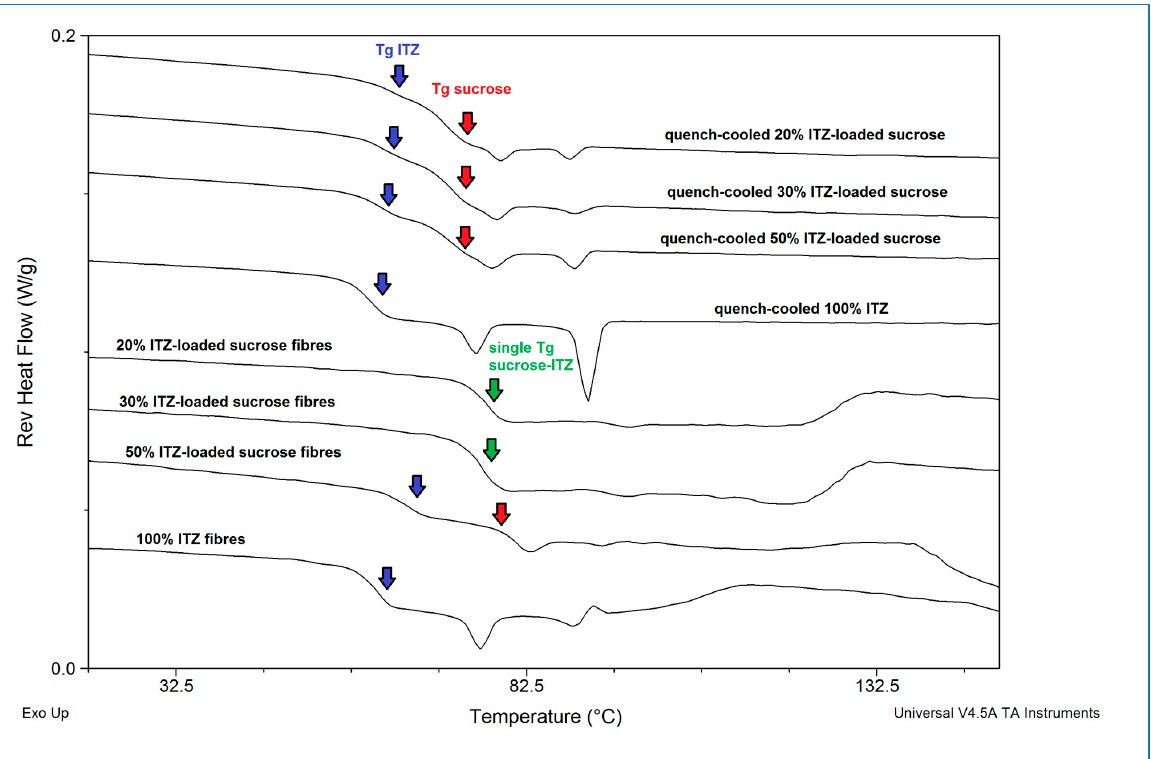
Figure 3. Reversing heat flow traces of freshly prepared itraconazole-loaded sucrose microfibres (containing 20, 30, and 50% w / w itraconazole), pure itraconazole microfibres, and solid dispersions with equivalent compositions prepared by quench-cooling from the melt. (ITZ = itraconazole). All samples showed glass transitional behaviour, indicating the generation of amor- phous dispersions. Interestingly, the quench-cooled sucrose-itraconazole samples all showed two separate glass transitions assigned to the individual components, with that of sucrose occurring at 68 ± 4.3 °C, indicated with a red arrow, and that of itraconazole occurring at 60 ± 0.2 °C, indicated with a blue arrow. These data indicate phase separation, i.e., lack of miscibility, of the two components, as discussed previously [35] for other sys- tems. Further evidence of phase separation is offered by the presence of the two endother- mic events occurring at around 74 and 90 °C, ascribed to the formation of a chiral nematic mesophase of pure itraconazole (90 °C) and rotational restriction of the molecules (74 °C) upon cooling from the melt, which are reversible upon re-heating, leading to the observed endotherms [36]. Both of these endothermic transitions and the glass transition are clearly visible for the quench-cooled pure itraconazole sample here. Microfibres containing 20 and 30% w / w itraconazole showed a single mixed-phase glass transition, indicated with a green arrow, at 74.7 ± 1.1 °C and 73.2 ± 1.3 °C, respectively, similar to that observed for the 10% w / w drug-loaded sample at 74.1 ± 1.9 °C [4]. Conversely, the thermal behaviour of the 50% w / w itraconazole-loaded microfibres was more similar to that of the corre- sponding quench-cooled sample, with both individual substance glass transitions and both itraconazole endothermic events being observed. It is interesting to note that the en- dothermic transitions are less pronounced for the microfibres, possibly indicating a lower degree of phase separation compared with the equivalent quench-cooled sample. The pure itraconazole microfibres showed the expected glass transition and endothermic tran- sitions. Taken together, these initial characterisation data suggest that the melt centrifugal process may increase the degree of mixing and miscibility of the drug (itraconazole) in the carrier (sucrose) compared with the simple melt quenching method, possibly due to the